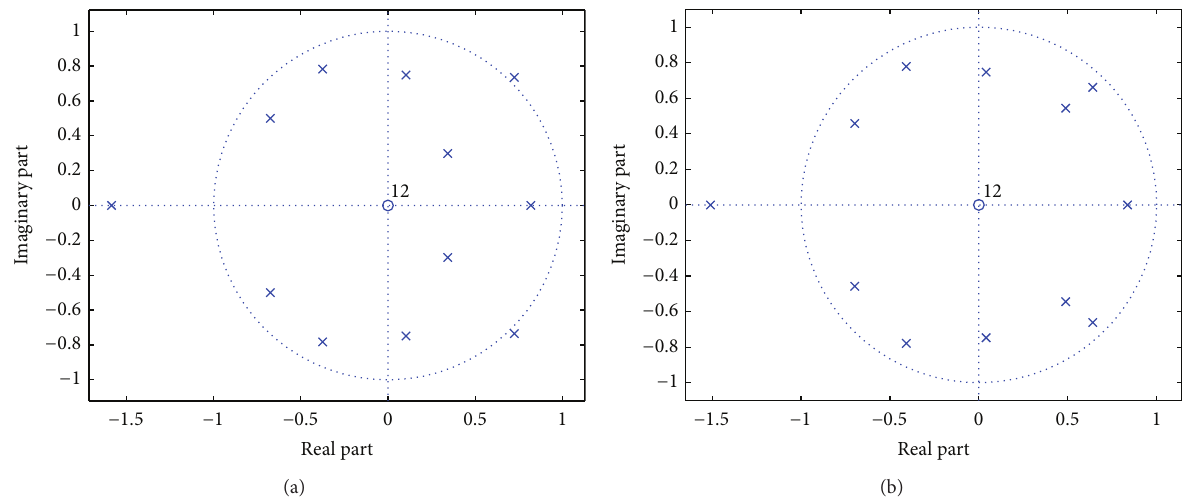
Figure 13: Mean Pole zero plots for vowel /e/ for person 1 for day 1 (left side) and day 2 (right side).